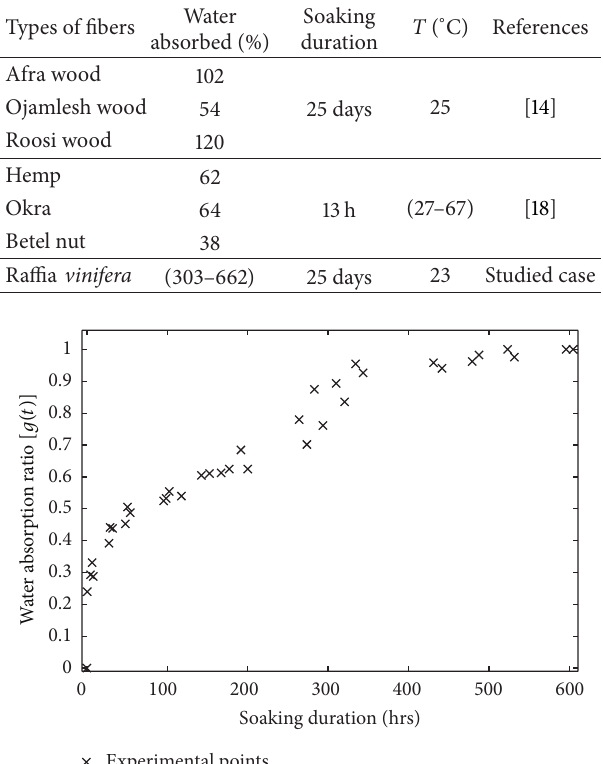
Figure 3: Curve of the kinetics of water absorption of Raffia vinifera fibres located at the half radius after the base of the stem (PL-2/4- R2).